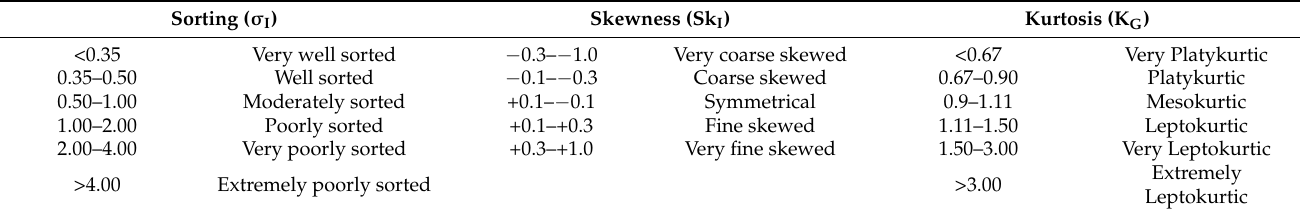
Table 1. Grain size parameters and grading standards adopted from Folk and Ward (1957)